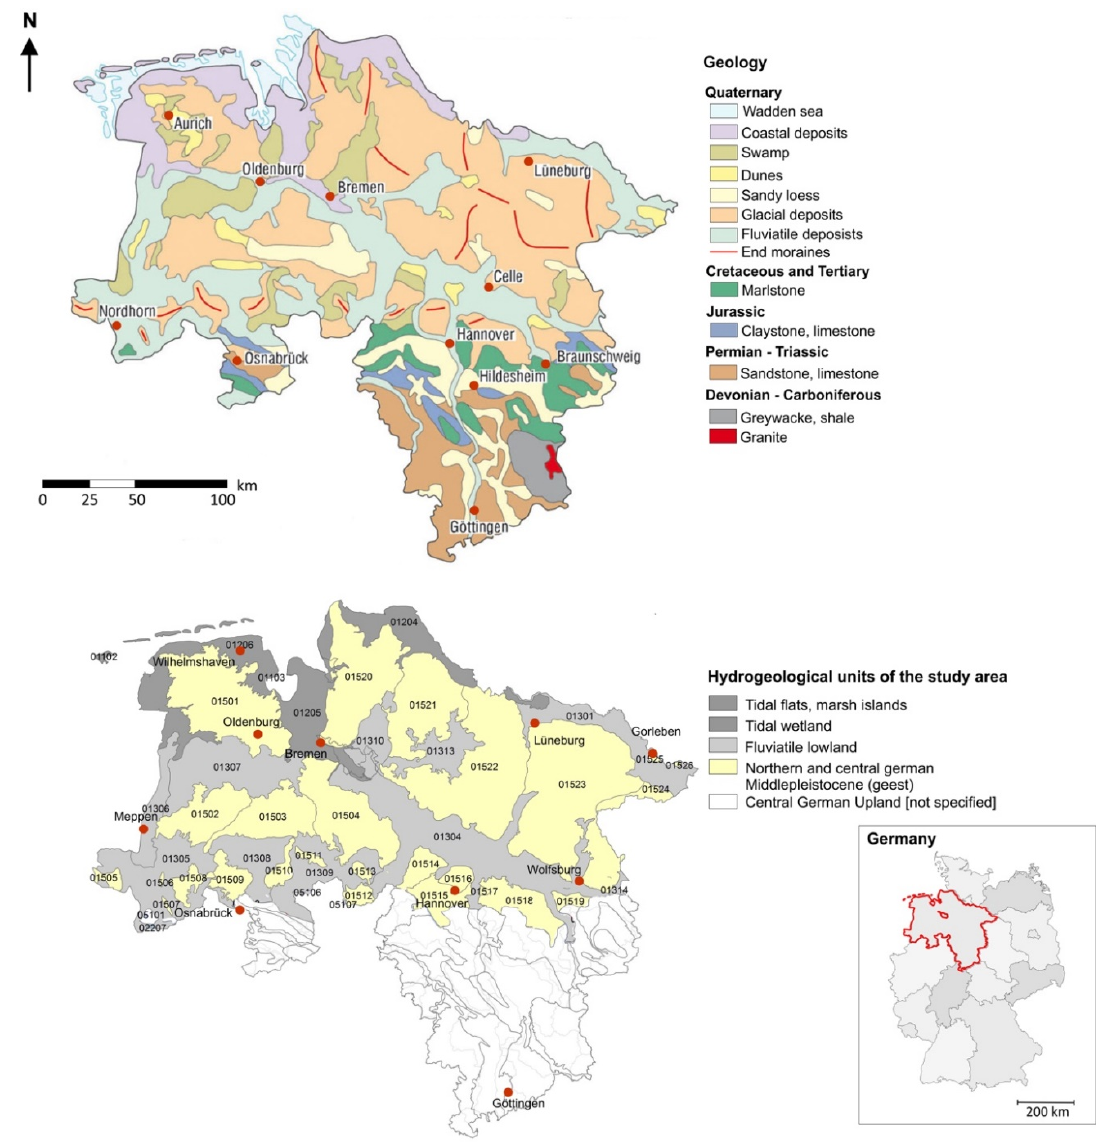
Figure 1. Geology of Lower Saxony and hydrogeological units of the study area in Northwestern Germany with respective subareas represented by code numbers (modified from Elbracht et al., 2016 and Heunisch et al., 2017).